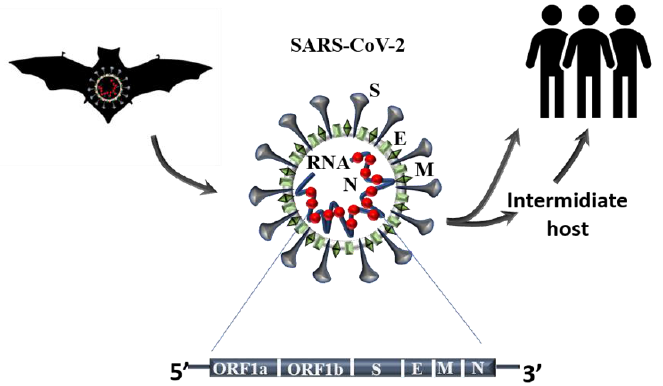
Figure 1. SARS-CoV-2 origin and molecular structure. The natural reservoir of the new betacoronavirus Sars-CoV-2 has been demonstrated to be bats and thought to spread to humans through an intermediate host. The viral RNA is associated with the N proteins that are involved in the key process of infection such as transcription, replication, and packaging. The lipid membrane that protects the viral RNA contains structural proteins such as membrane (M) and envelope proteins (E). The spike glycoprotein (S), through its receptor-binding domain, is responsible for the recognition of the host cell receptor. The picture shows a simplification of the viral genome.